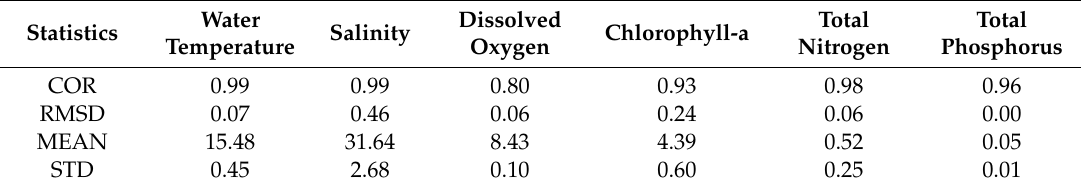
Table 3. Statistical quantities of the reconstructed spatial distribution for six